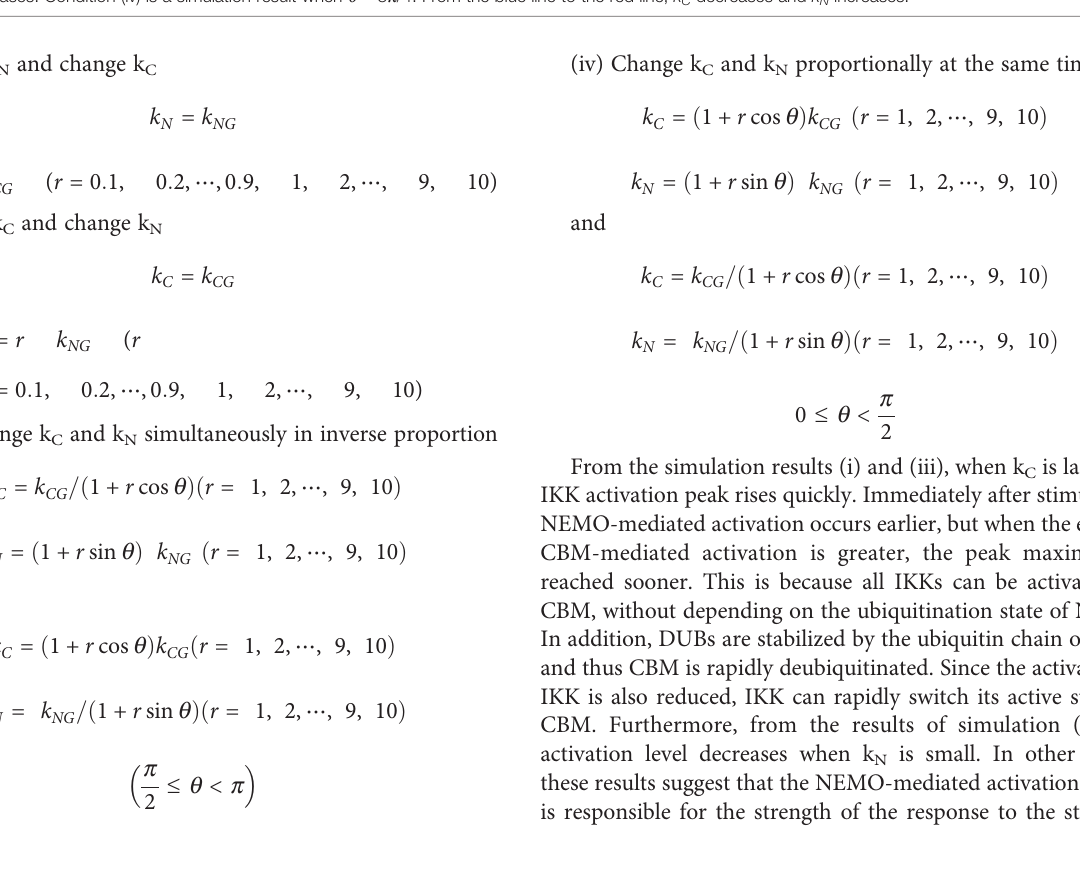
FIGURE 6 | Mathematical simulation of the effects of linear ubiquitination of the CBM complex and NEMO on the TCR-mediated IKK activation. (A) LUBAC ubiquitinates NEMO and the CBM complex. In this model, ubiquitination is assumed to be a fi rst-order reaction. (B) Fitting result by GA. Solid lines represent simulation results, and dots represent experimental data. (C) The simulation results of IKK activation, changing k C and k N . From the blue line to the red line, k C increases under condition (i), and k N increases under condition (ii). Condition (iii) is a simulation result when q = p /4. From the blue line to the red line, k C increases and k N decreases. Condition (iv) is a simulation result when q = 3 p /4. From the blue line to the red line, k C decreases and k N